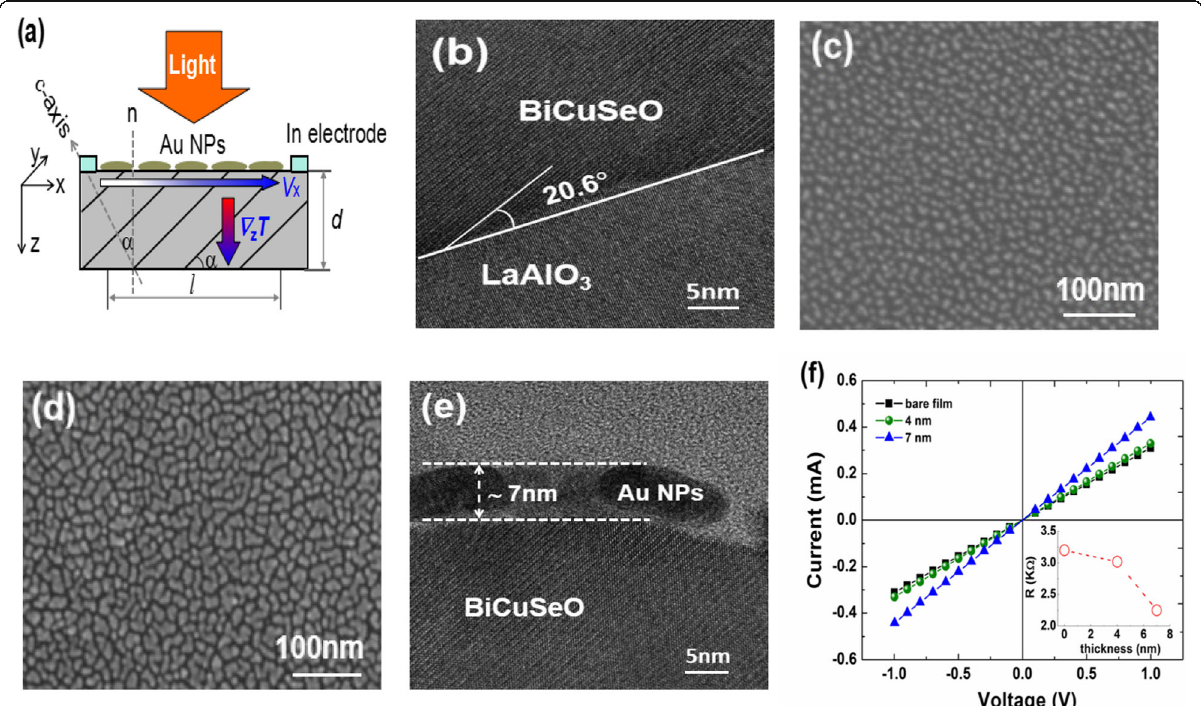
Fig. 1 a Schematic illustration of the LITT effect in a c -axis tilted film coated with AuNP layer. b HRTEM image of a BiCuSeO film grown on 20° miscut LaAlO 3 (001) substrate. c – d SEM images of the AuNP layer with thickness of 4 and 7 nm, respectively. e HRTEM image of the sample of AuNP (7nm)/BiCuSeO. f I – V curves between two indium electrodes on different samples. The inset is the variation of resistance of AuNPs/BiCuSeO samples with the AuNP layer